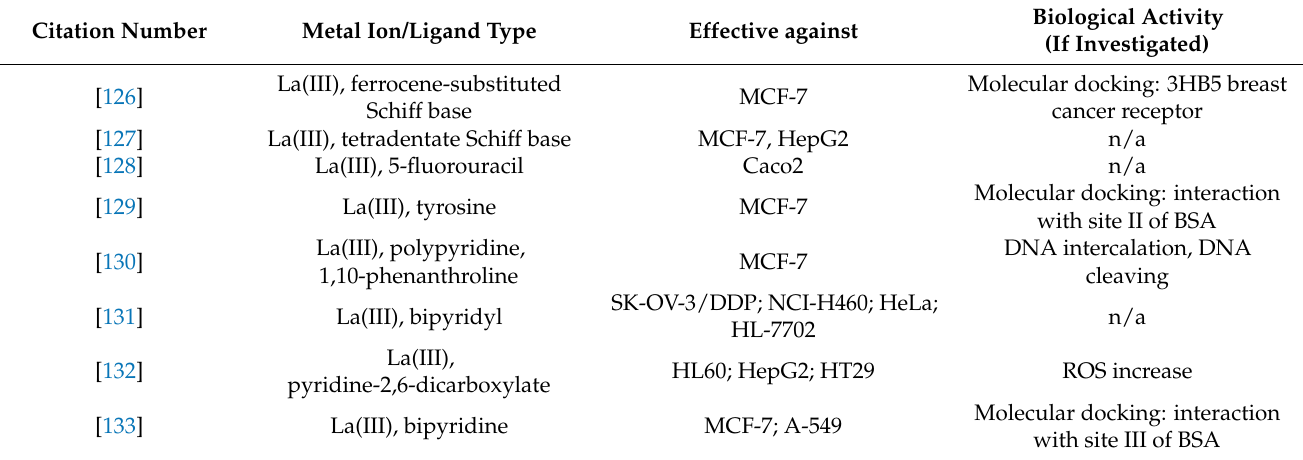
Table 5. Summary of the lanthanum complexes